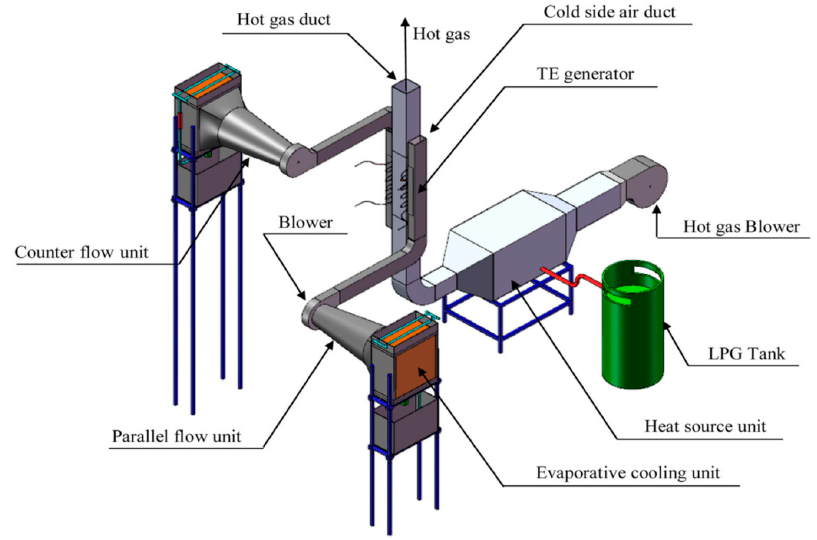
Figure 11. Schematic of an evaporative cooling system for TEG [77].